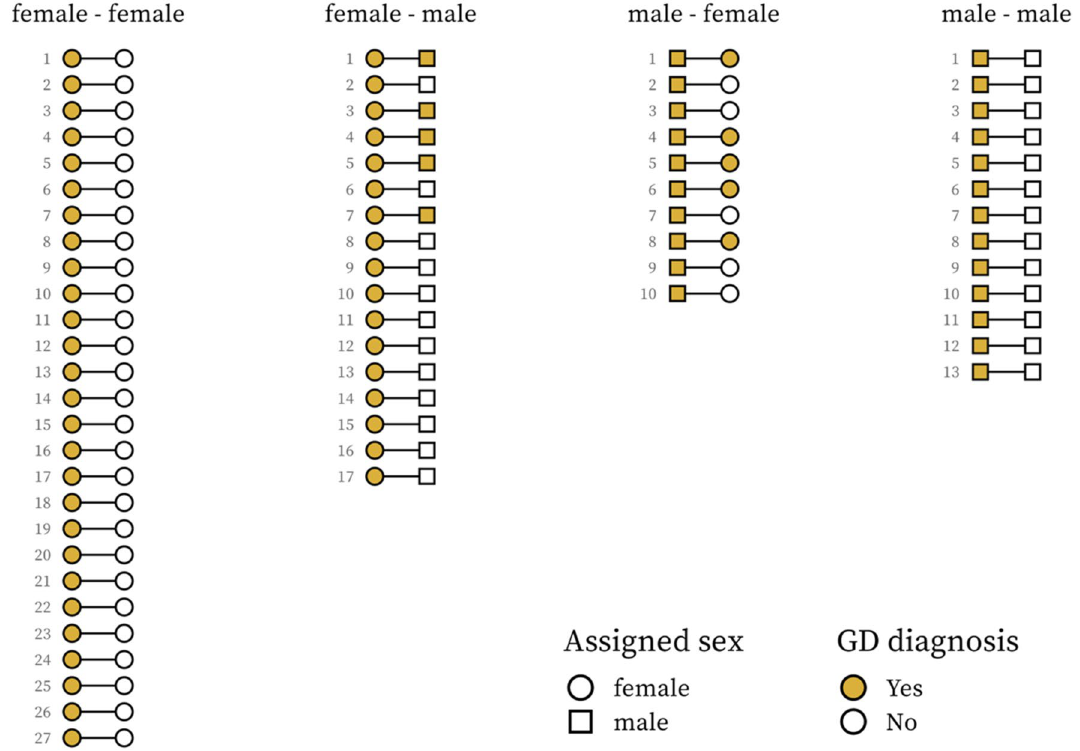
Figure 2. Gender dysphoria (GD) diagnosis among twins by proband and co-twin assigned sex.